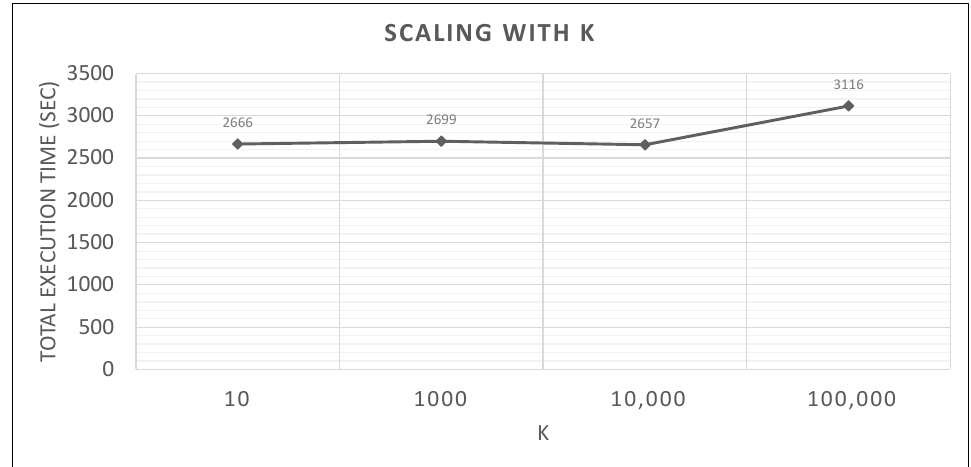
Figure 29. Spark scaling with K , small synthetic query vs. medium training datasets.